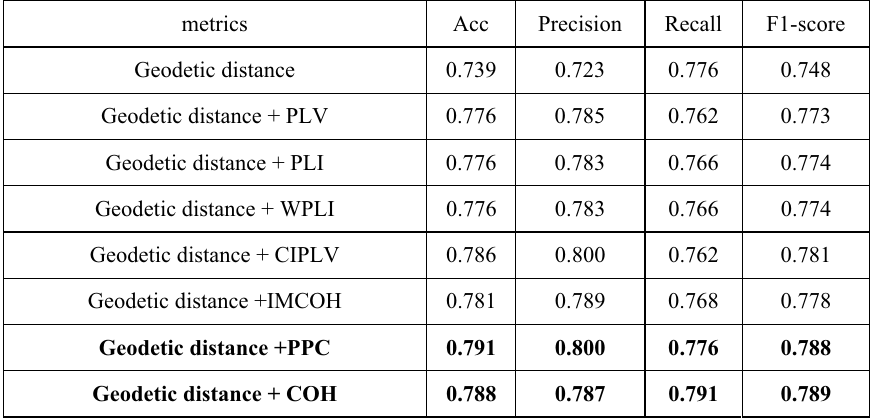
Table 2. Comparison of different method for constructing adjacency matrix of